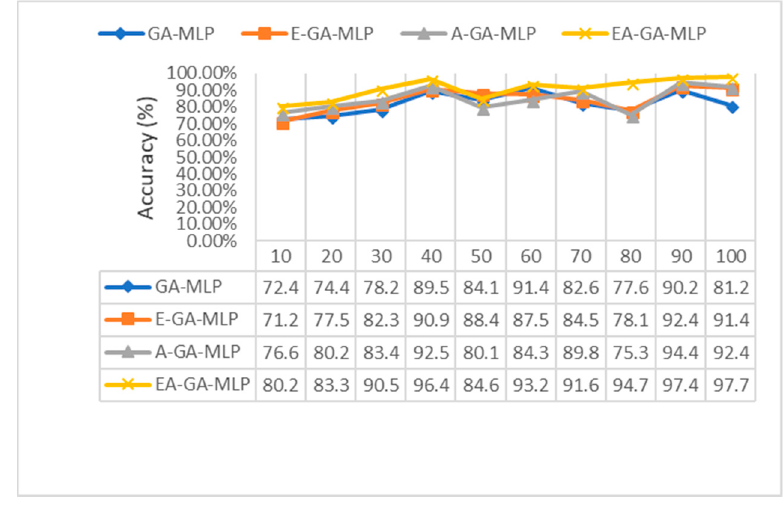
Figure 10. Comparative analysis of Classification Accuracy w.r.t number of Generations.